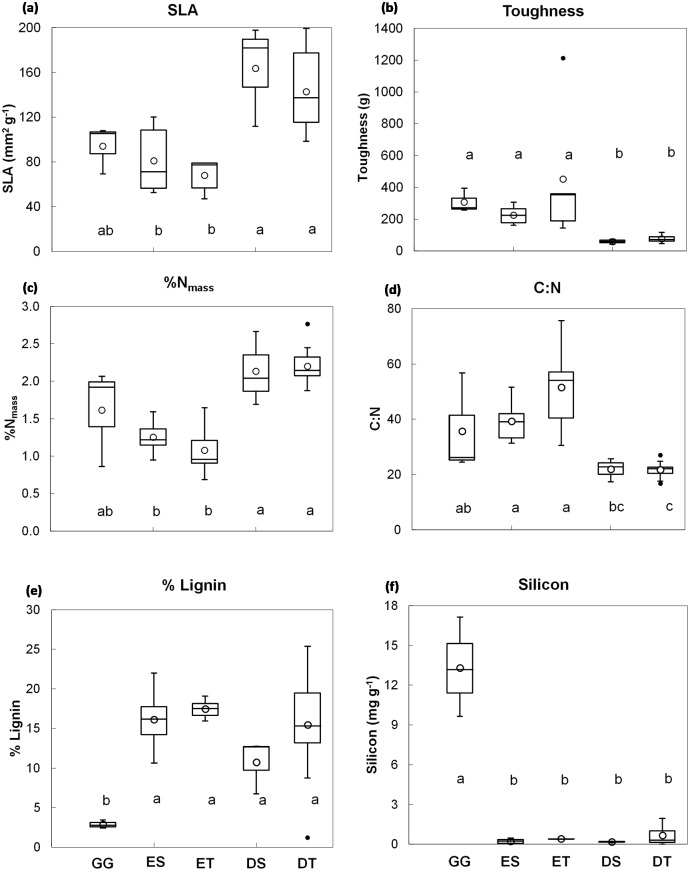
Box-and-whisker plots for selected leaf trait variables of the five plant functional types studied.Giant graminoids (GG), evergreen shrubs (ES), evergreen trees (ET), deciduous shrubs (DS) and deciduous trees (DT). Box represents median and 25th and 75th percentile levels, open dot is the mean, whisker is the range, and closed dots are outliers. Different letter indicates significant (P < 0.05) differences among plant functional types.